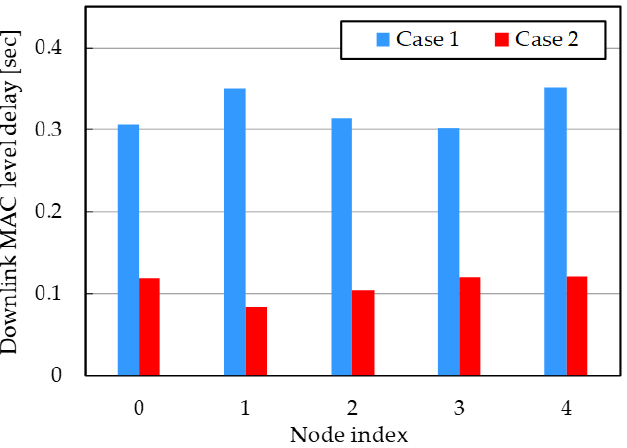
Figure 7. Downlink MAC level delay for each node in simplified topology (38 Mbps offered load). Table 4. Summarized delay values in simplified